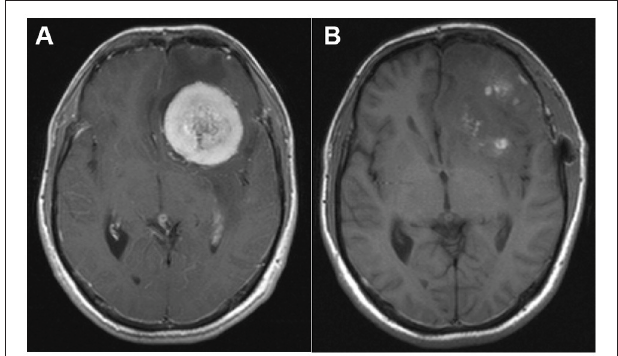
FIGURE 1 | (A) Pre-operative magnetic resonance imaging (MRI; T1-weighted sequence after gadolinium enhancement) showing a large mass with regular borders and surrounding edema, exerting a mass effect on the adjacent frontal lobe and a 12-mm left-to-right midline shift. (B) Post-operative MRI (T1-weighted sequence after gadolinium enhancement) demonstrating complete tumor